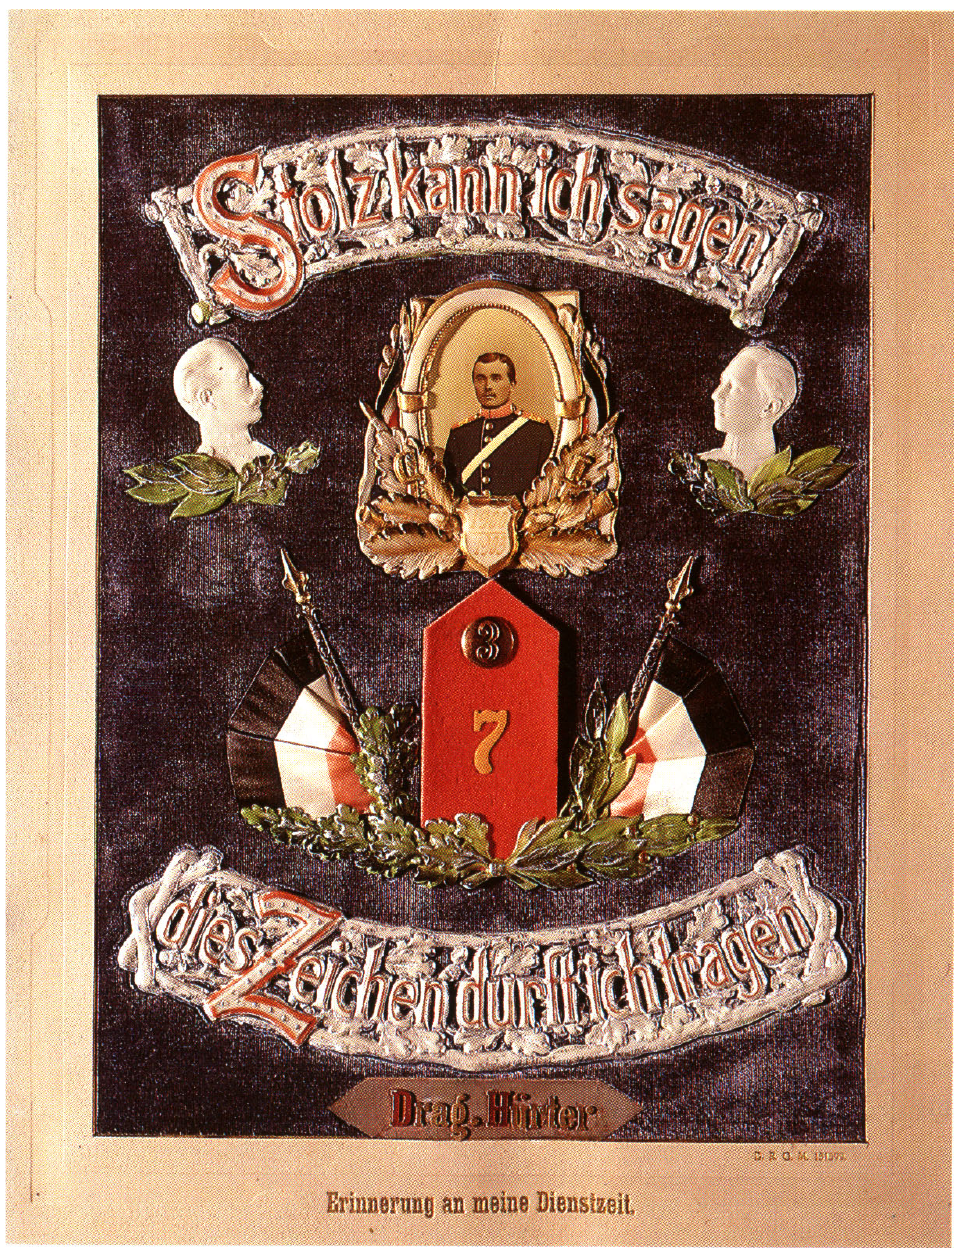
Figure 5 Carl Dreesen, Dragoner Hürter (Dragooner Hürter). 1903. Assemblage of hand-colored albumin print, plastic, metal, velvet, and silk. Collection of Museum Folkwang, Essen. 48.5 x 36.7